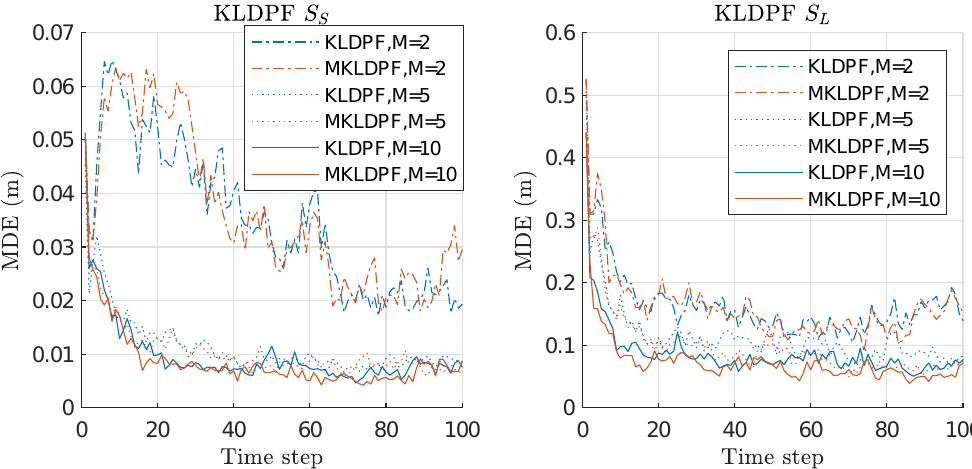
Figure 10. Mean distance error (MDE) performance comparison between Kullback–Leibler divergence-PF (KLDPF) and minimax KLDPF (MKLDPF). Three hundred runs were performed